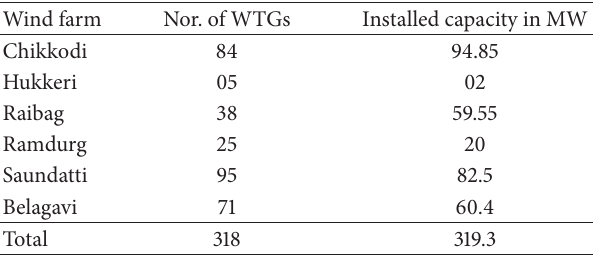
Table 1: Details of Belagavi district wind turbine